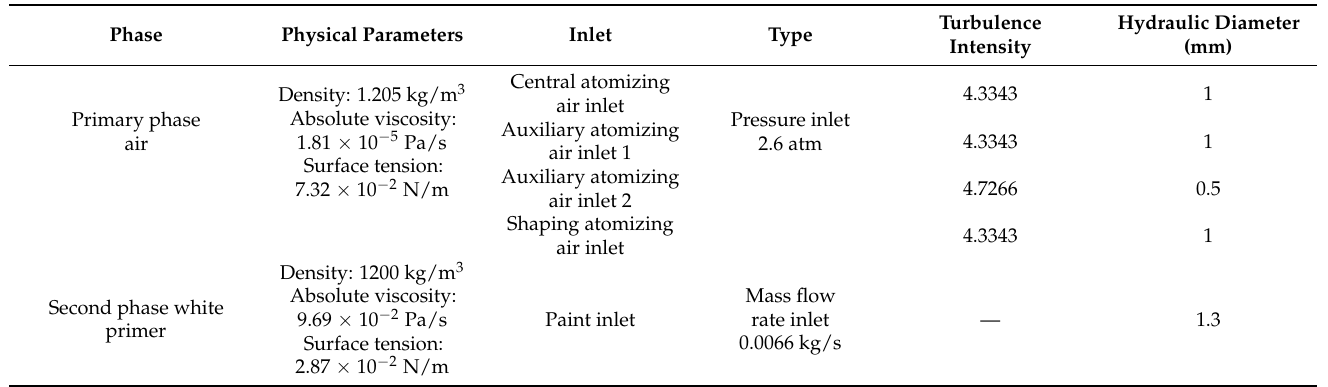
Table 2. Gas and liquid physical parameters and corresponding inlet conditions.